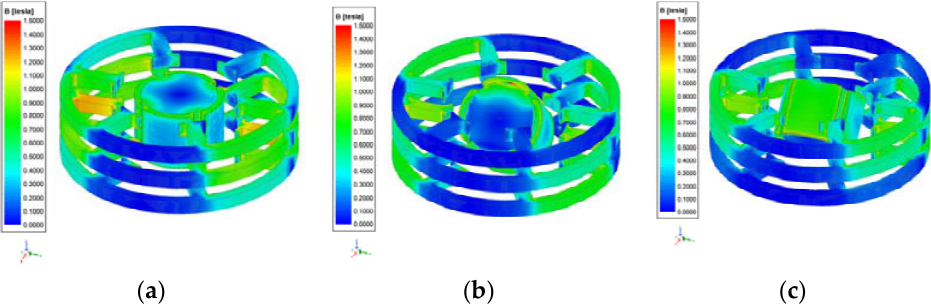
Figure 8. Magnetic field distributions of the motor at loaded conditions rotating around the X ‐ axis: ( a ) view of the motor that is at α = 0°; ( b ) view of the motor that is at α = +45°; ( c ) view of the motor that is at α = − 45°.